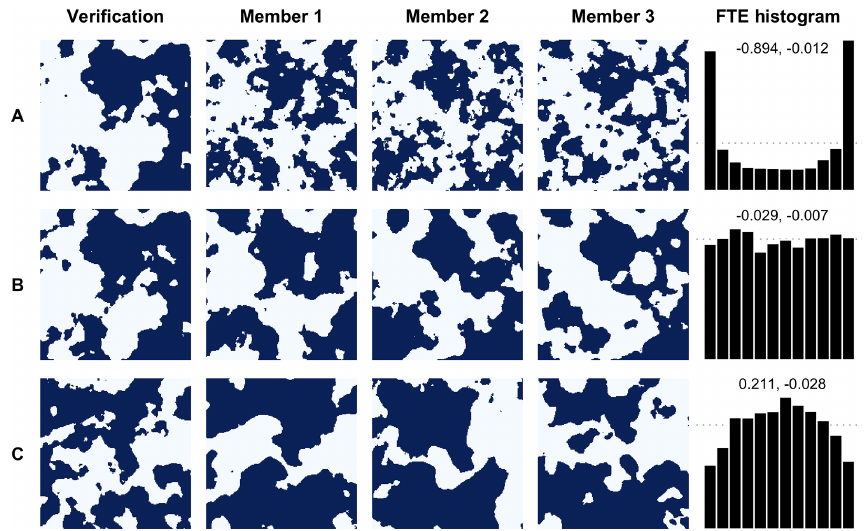
Figure 2. Example binary exceedance verification field and a subset of ensemble fields with representative FTE histogram for threshold τ = 0 found using 5000 samples. Dark blue regions indicate threshold exceedance. All verification fields have correlation length a 0 = 2 and ensemble fields have correlation length a M = 1 , 2 , 3 in rows A, B, and C, respectively. FTE histograms are density histograms with dotted line y = 1 and corresponding β -score (left) and β -bias (right) annotated.